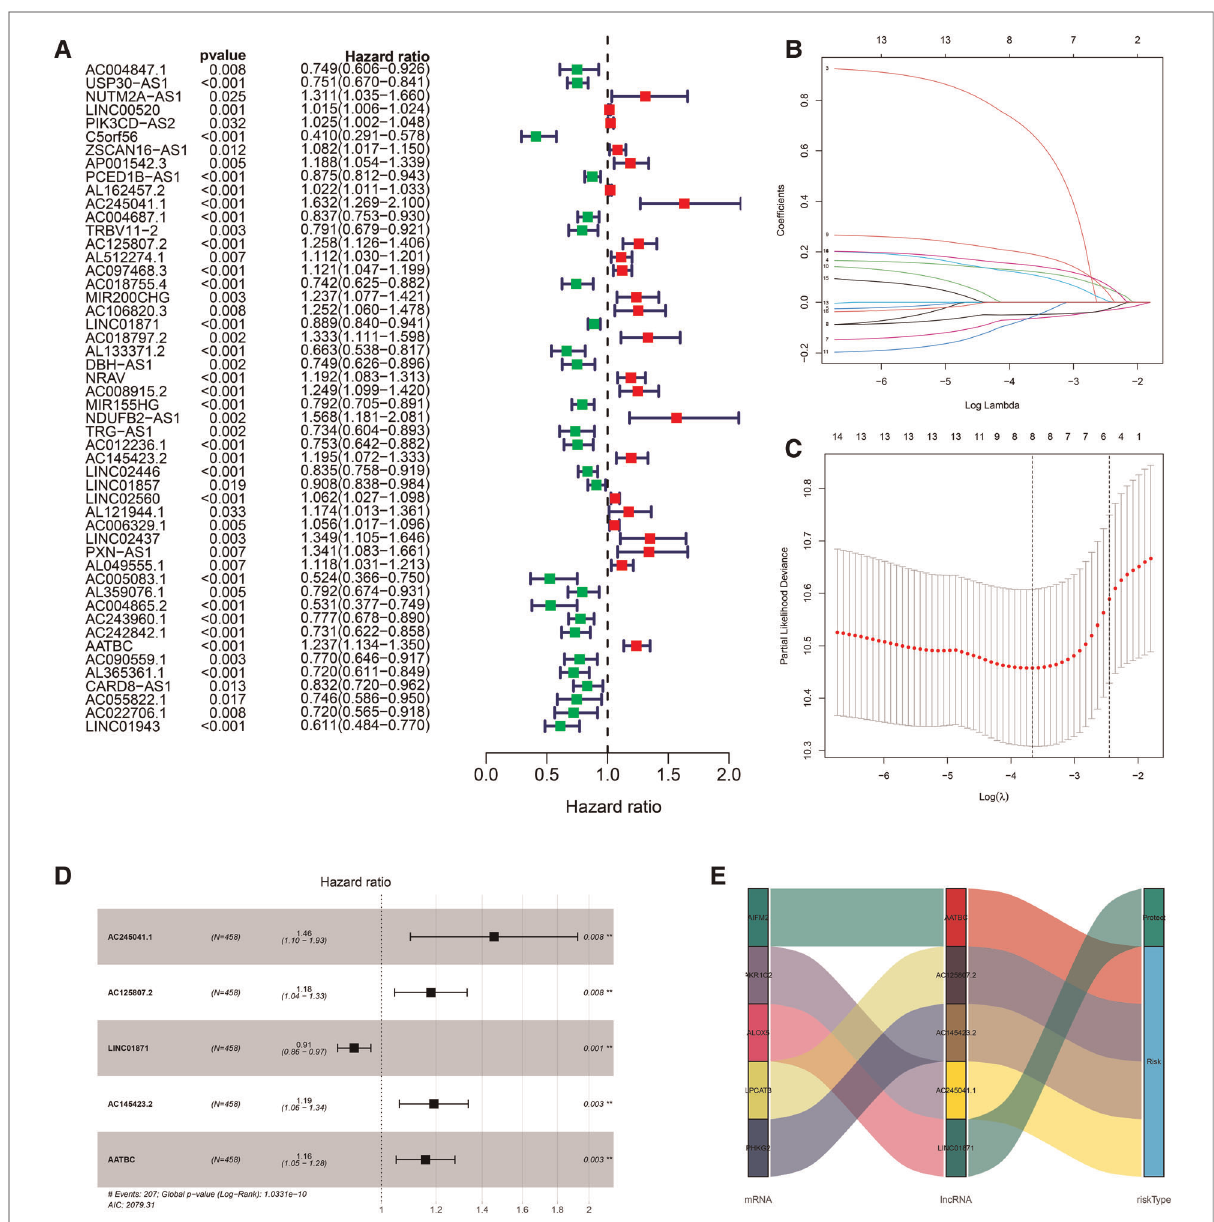
FIGURE 2 Construction of the prognostic ferroptosis-related lncRNA signature. ( A ) Univariate Cox regression revealed that 50 of the 161 FDELs were associated with OS. ( B ) LASSO regression identi fi ed 8 FDELs from the 50 lncRNAs, Dynamic LASSO coef fi cient pro fi ling. ( C ) Selection of the tuning parameter (lambda); and the dashed lines on the left and right indicate the “ lambda. min ” and “ lambda.1se ” criteria, respectively. ( D ) Stepwise Cox regression fi nally identi fi ed 5 FDELs (AATBC, AC145423.2, LINC01871, AC125807.2, and AC245041.1) to construct the risk score ( P <0.001). ( E ) Sankey diagram shows the associations among FDELs, FDEGs, and risk